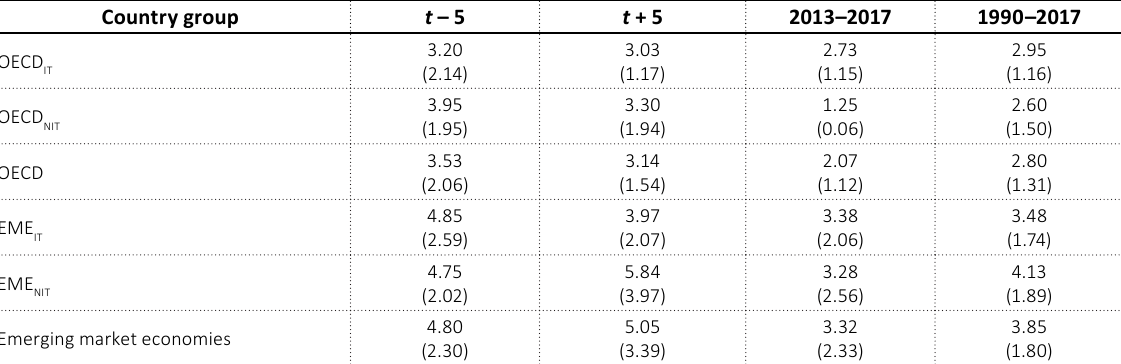
Table 3. Real GDP per capita growth in OECD and emerging market economies,